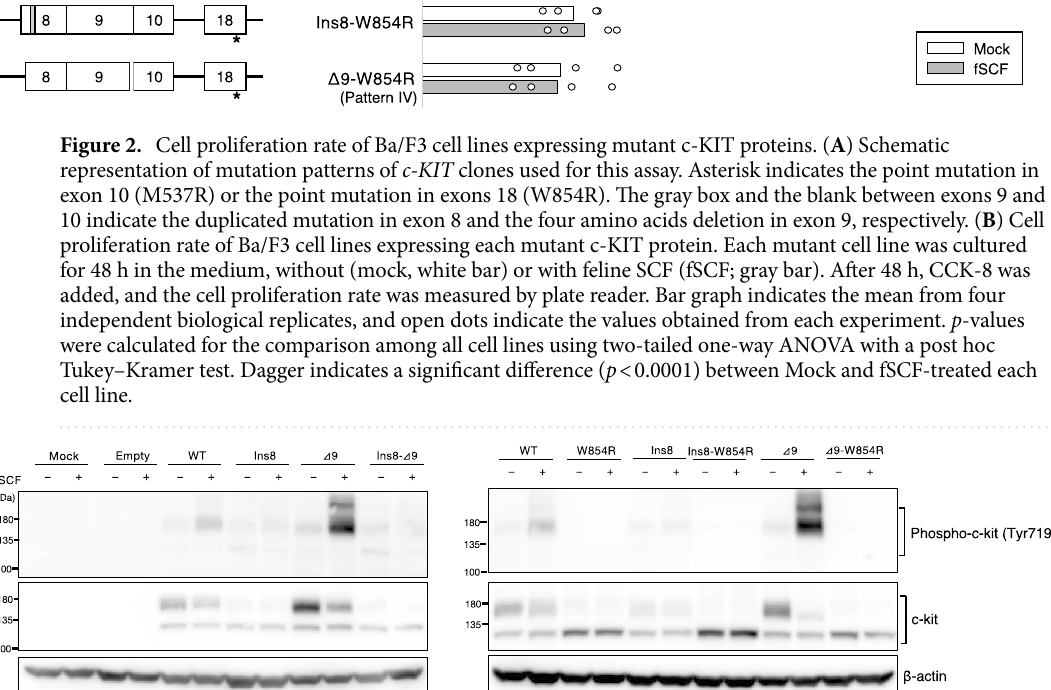
Figure 3. Phosphorylation status of c-KIT in Ba/F3 cells expressing the mutant c-KIT . Ba/F3 cell lines stably expressing mutant forms of c-KIT protein were cultured in plain RPMI for 2 h and stimulated with fSCF (100 ng/ml) for 5 min. After stimulation, cells were collected and the extracted whole cell lysates were conducted for SDS-PAGE, followed by western blotting with anti-phospho-c-KIT (Tyr719), anti-Flag (M2), and anti-β- actin antibodies. A representative result of three independent experiments is shown. Full image of western blotting is shown in Supplementary